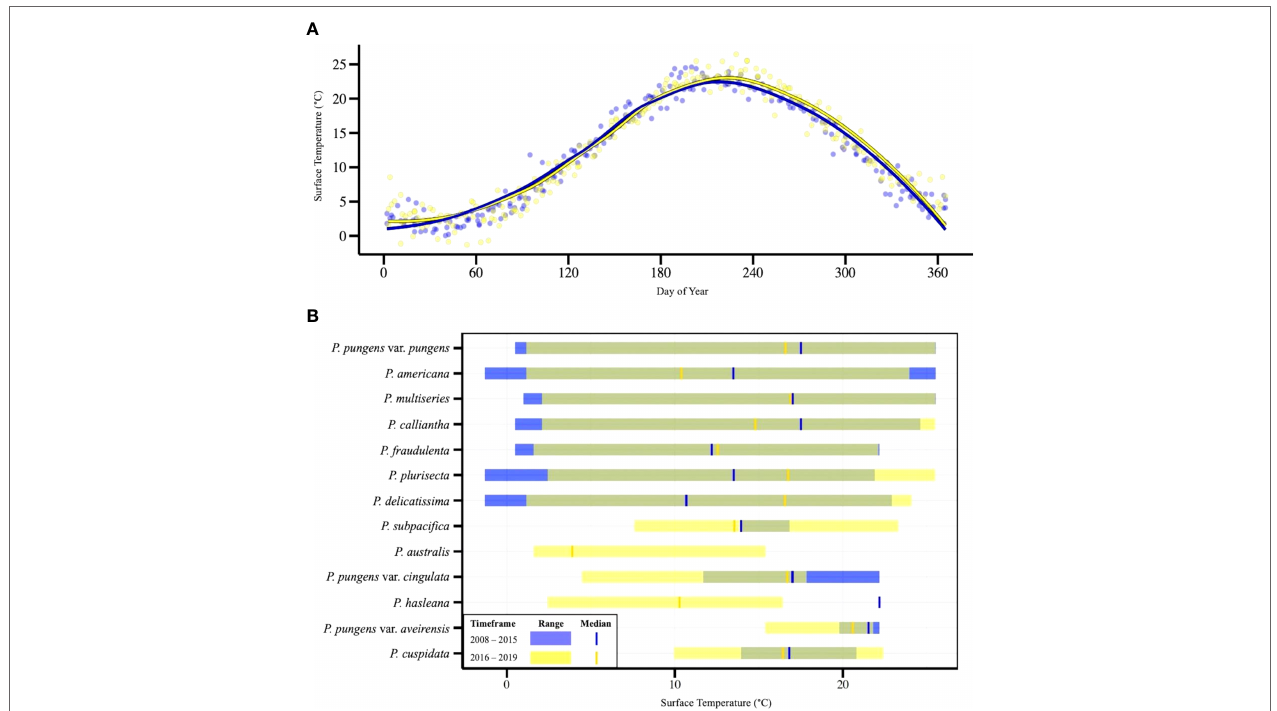
FIGURE 5 | (A) Sea surface temperature at the NBPTS site over an annual cycle with two loess smoother lines representing the timeframes before (2008-2015; blue) and during/after closures (2016-2019; yellow). (B) Thermal ranges of Pseudo-nitzschia species that were found in >5% of samples. Ranges are based on sea surface temperature of presence/absence occurrence during two timeframes. Samples from 2008-2015 are shown in blue; 2016-2019 are shown in yellow. Temperatures for which the temporal thermal ranges overlap appear in green. The median temperature at which species are observed prior to 2015 are represented by vertical blue bars and after 2016 by vertical yellow